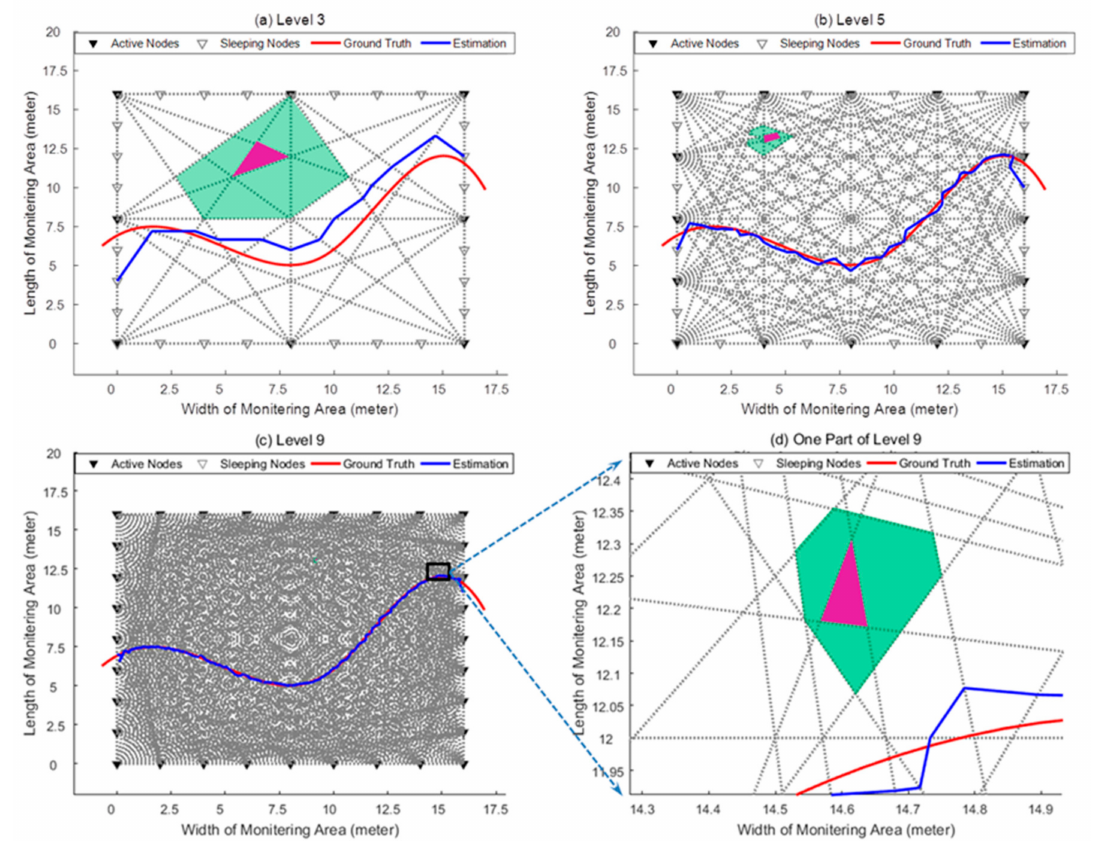
Figure 9. Tracking results under different levels.